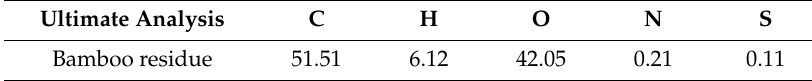
Table 2. Ultimate analysis of bamboo residual, %.